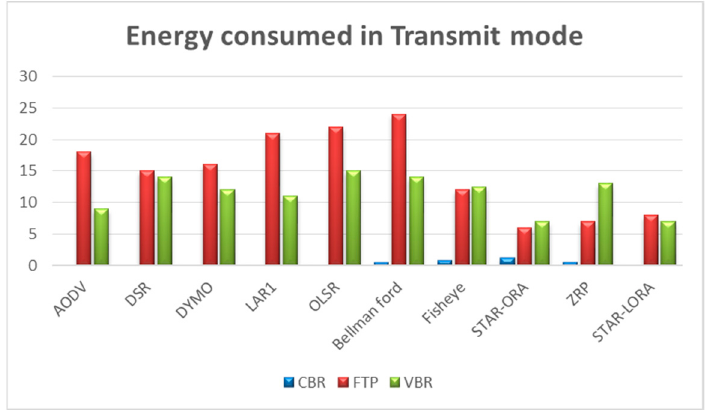
Figure 13. Transmit mode energy consumption of all routing protocols for 120 nodes.